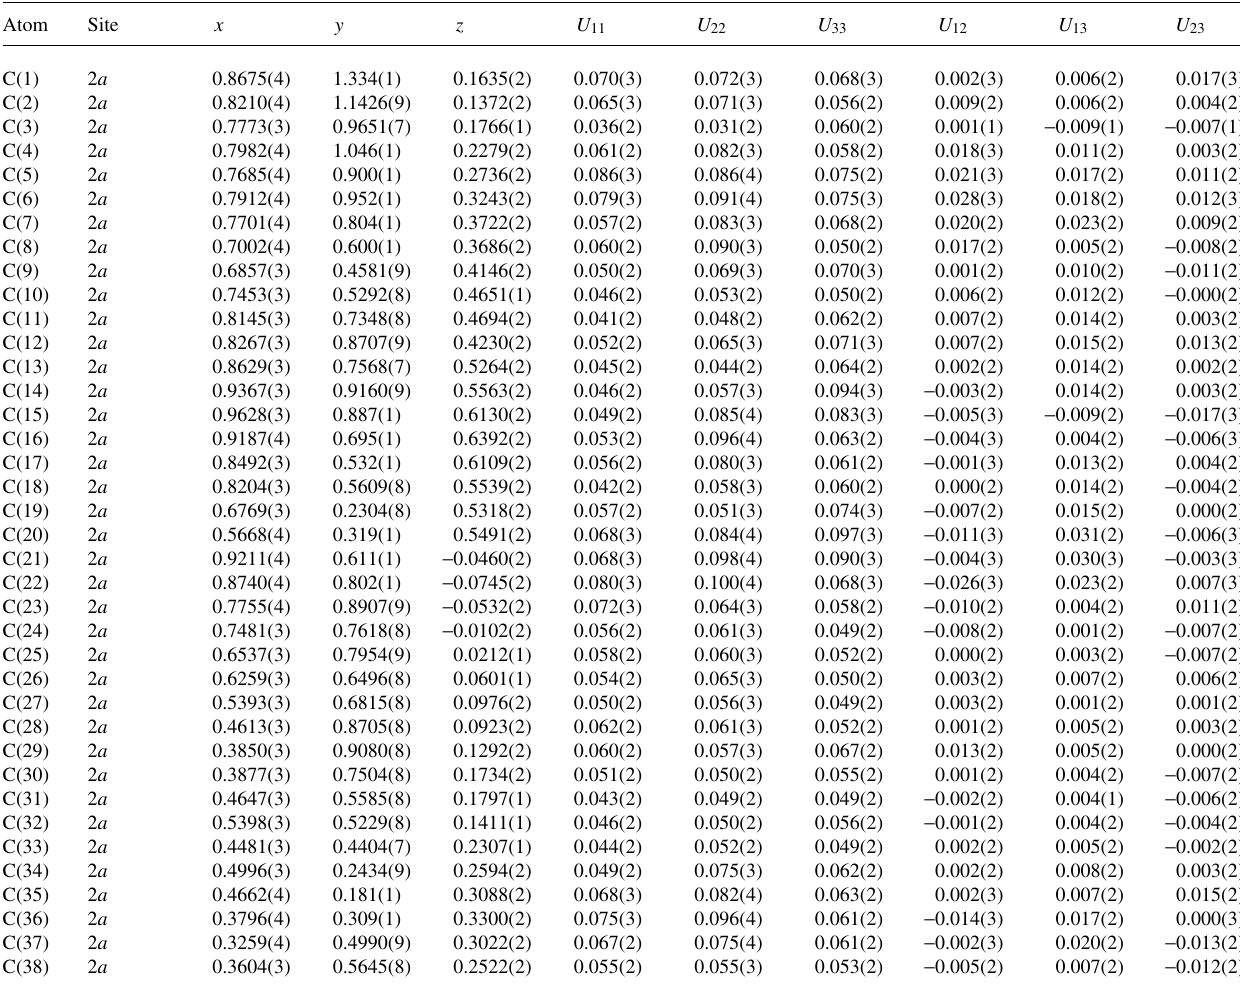
Table 3. Atomic coordinates and displacement parameters (in Å 2 ) .